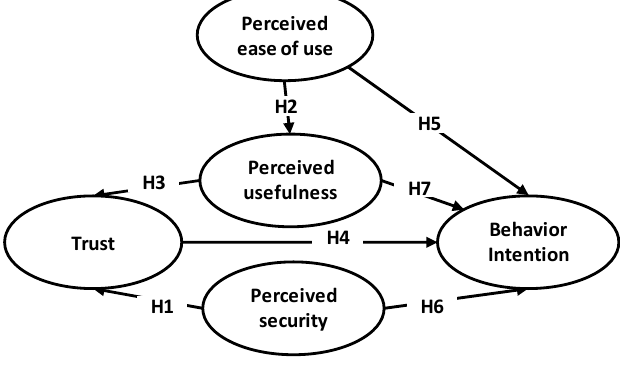
Fig. 1 . Research Framework and Hypotheses